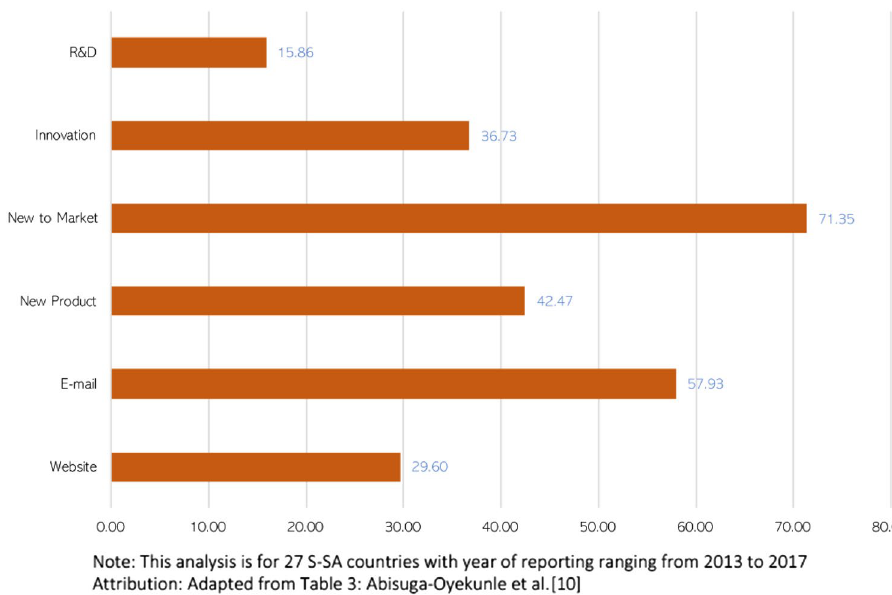
Fig. 5 Summary of Percent- age of S-SA Firms Engage- ment in Innovation and